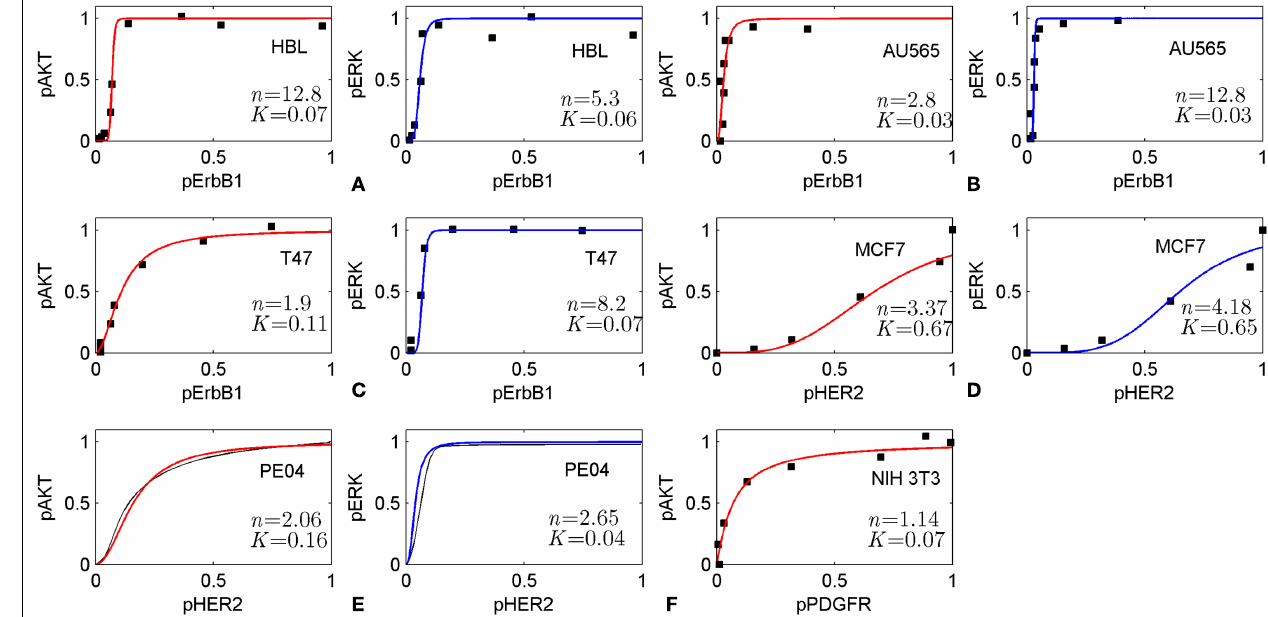
FIGURE 6 | Input/output responses of PI3K/AKT and MAPK pathways to the activation of growth factor receptors in different cells .The dependences of p AKT and p ERK on the activation level of ErbB1 receptors in HBL100 (A) , AU565 (B) ,T47 (C) cells; on the level of HER2 receptors in MCF7 (D) and PE04 (E) cells; and platelet-derived growth factor receptor (PDGF) in NIH 3T3 fibroblasts (F) . Data on I/O response were extracted from experimental dose dependences [ (A–C) (49), (D) (54), and (F) (55)] and